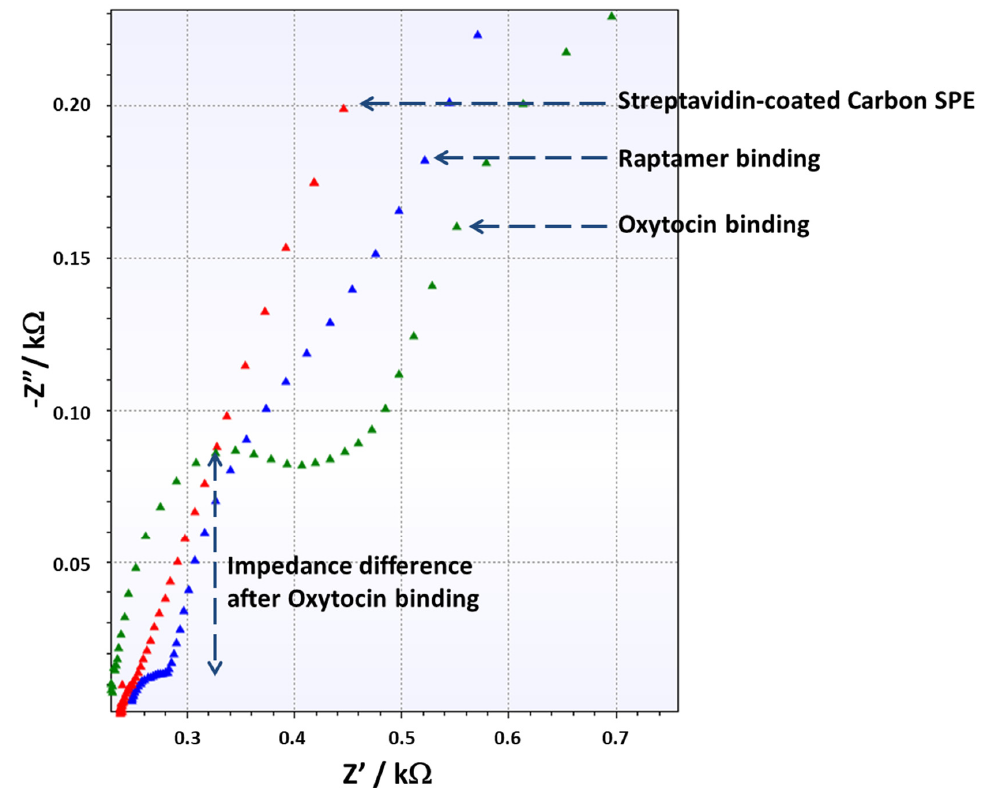
Figure A1. Nyquist plots for Streptavidin coated Carbon SPE, biotinylated Raptamer immobilization onto the electrode and Oxytocin binding to the Raptamer.